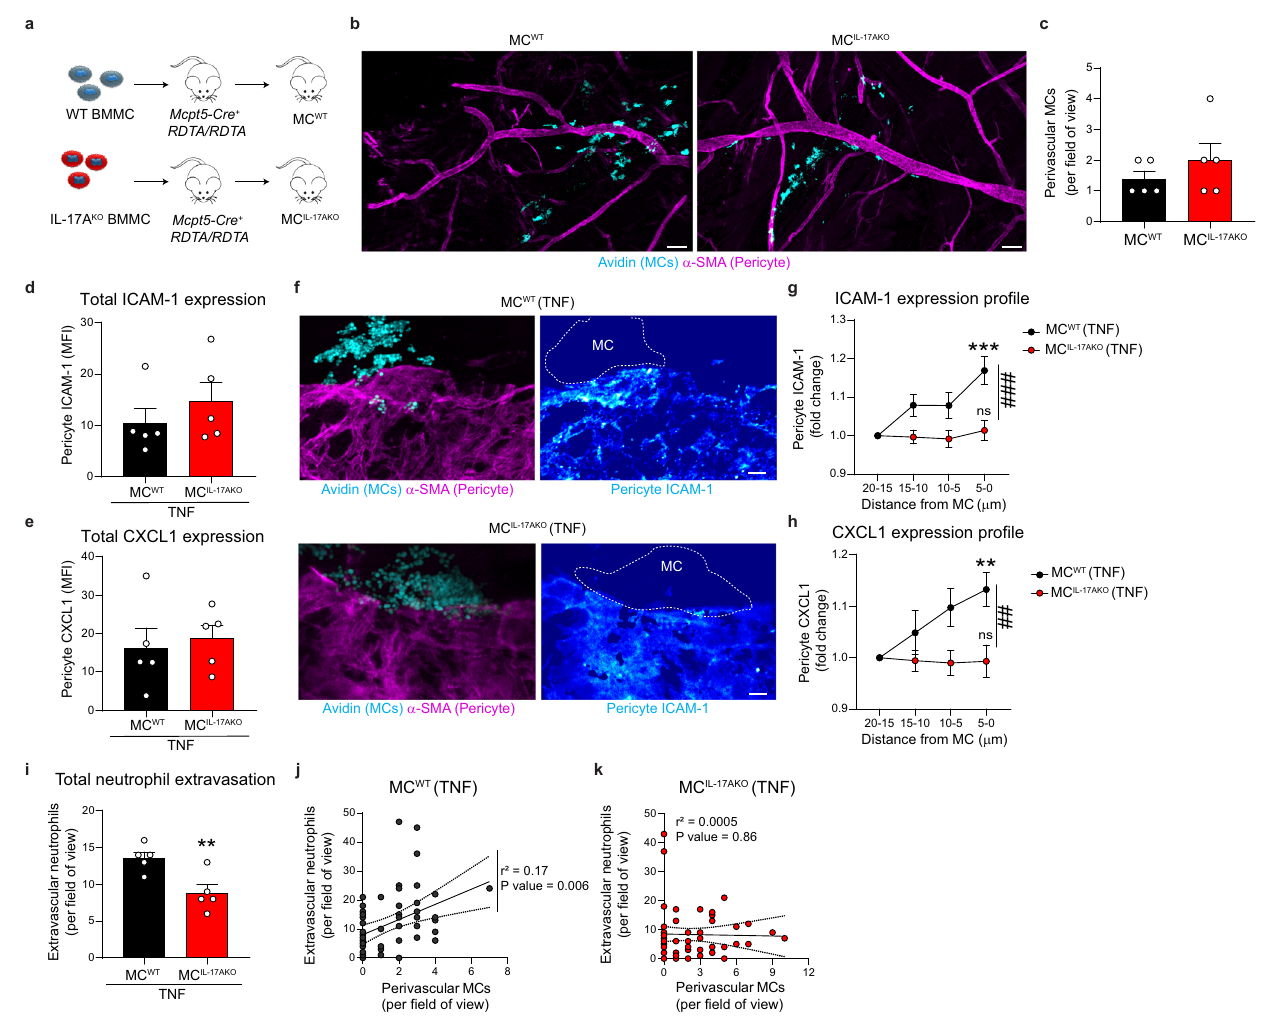
Fig. 6 | MC-derived IL-17A induces graded expression of ICAM-1 and CXCL1 in pericytes. MC de fi cient animals were injectedwith BMMC from WT (MC WT ) or IL-17A KO (MC IL-17AKO ) mice. Four months later, MC-reconstituted mice were stimulated with TNF (300ng) for 4h. Cremaster muscles were collected and immunostained for neutrophils (MRP14), MCs (avidin), pericytes ( α -SMA) and ICAM-1 or CXCL1. a Generation of MC-reconstituted mice. b Low-magni fi cation image of the cre- masteric microcirculation in MC WT and MC IL-17AKO mice depicting the reconstitution of MCs, scale bars 100 µ m. c Number of perivascular MCs in MC WT and MC IL-17AKO mice ( n =5 mice). d , e Quanti fi cation of d ICAM-1 and e CXCL1 MFI on pericytes ( n =5 mice). f Images of post-capillary venules in TNF-treated MC WT and MC IL-17AKO mice showing increased expression of ICAM-1 in MC WT butnotinMC IL-17AKO miceon pericytes,scalebars5 µ m. g Quanti fi cationofpericyteICAM-1MFIinregionsat5 µ m interval from a perivascular MC in TNF-treated MC WT and MC IL-17AKO mice ( n =28 MC WT , 27 MC IL-17AKO perivascular MC regions, data pooled from fi ve mice, *** p